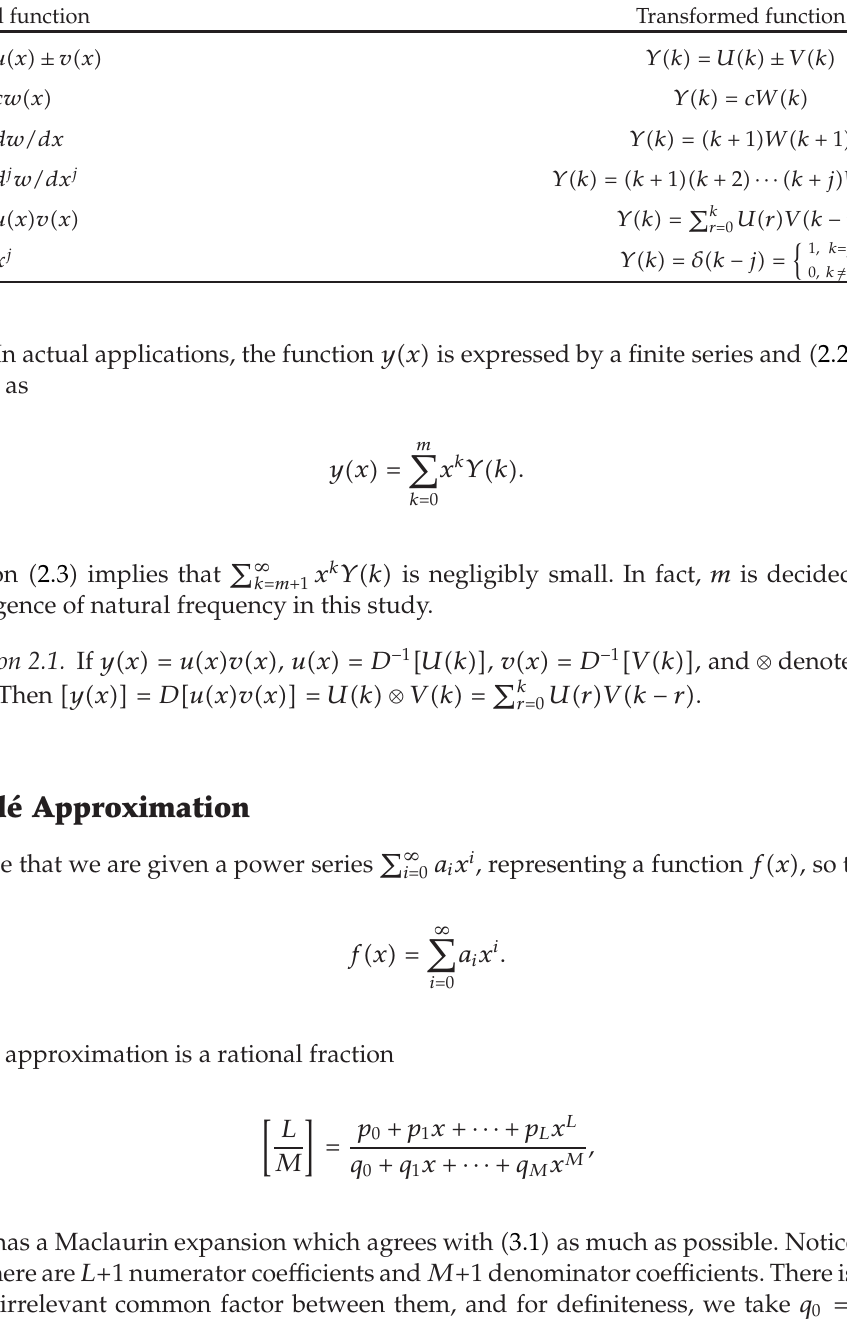
Table 1: The fundamental operations of one-dimensional di ff erential transform method. Original function Transformed